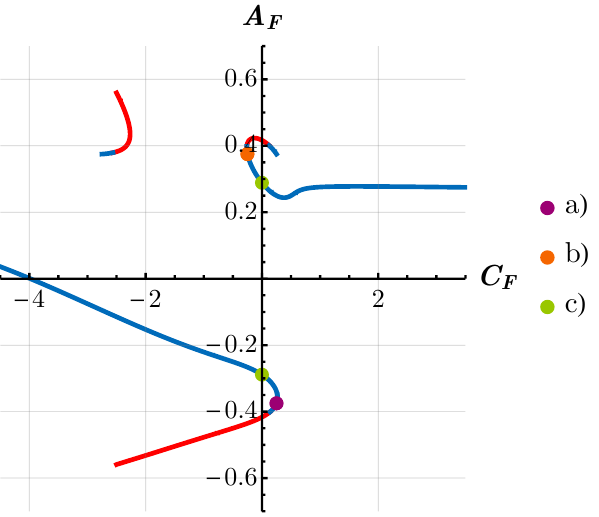
Figure 2 . Set of points that verify (4.35) with E 2 ≥ 0 and: have no tachyons violating the BF F bound and therefore are perturbatively stable (blue curve); have tachyons violating the BF bound and therefore are perturbatively unstable (red curve). The colored dots correspond to the particular solutions